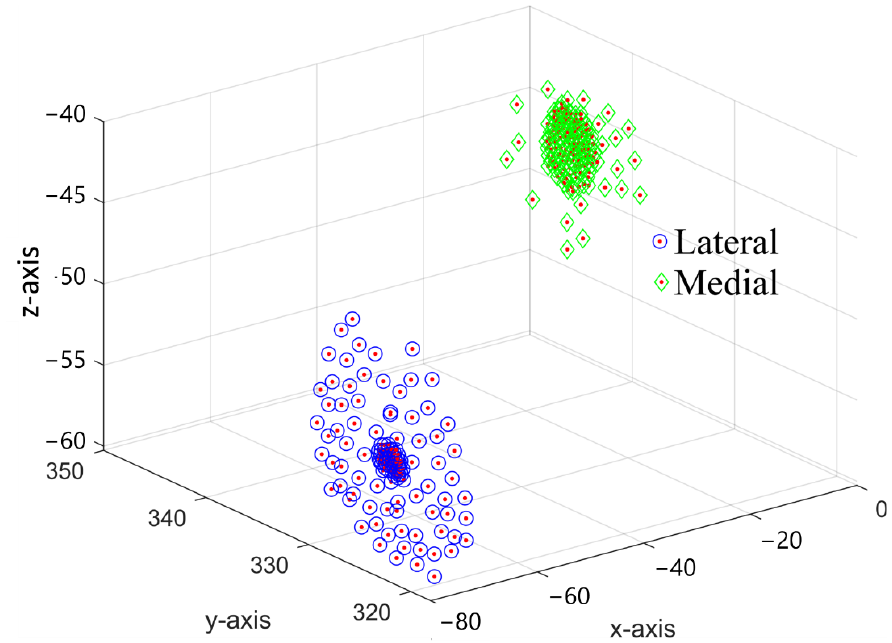
Figure 9. Clouds of lateral and medical points on epicondyle. Based on the marked points, the algorithm defined FCS using each point, and com- pared its orientation with FCS defined by aTEA. For example, first, a constant LE marked on the bone is used while calculating ME by the proposed method. To get a new ME, each point marked in PG along with KC and FHC is used to define the C PG plane. Based on the largest perpendicular distance, ME is chosen from the medial cloud. FCS is defined using the obtained points, and its orientation is compared with reference FCS defined using the marked aTEA, as described in Figure 6. Since the y-axis is the same in both FCSs, the angle between the z-axis is measured to obtain the orientation error. Once all points are used to define C PG , ME is kept constant, and points marked in N are used to define C N , to find the LE from the lateral cloud. Table 3 compares the orientation error between the FCSs obtained by Whiteside’s line, aTEA, and the proposed modified Whiteside’s line. The orientation error is measured by defining an anatomical point 3 mm away from its ideal position. To measure the error, first FCS is defined using an ideal anatomical point, then the anatomical point is marked with 3 mm of error in a lateral or medial direction to define a second FCS. Finally, the orientation between the first and second FCSs is measured to check the effect of 3 mm error on that anatomical axis.